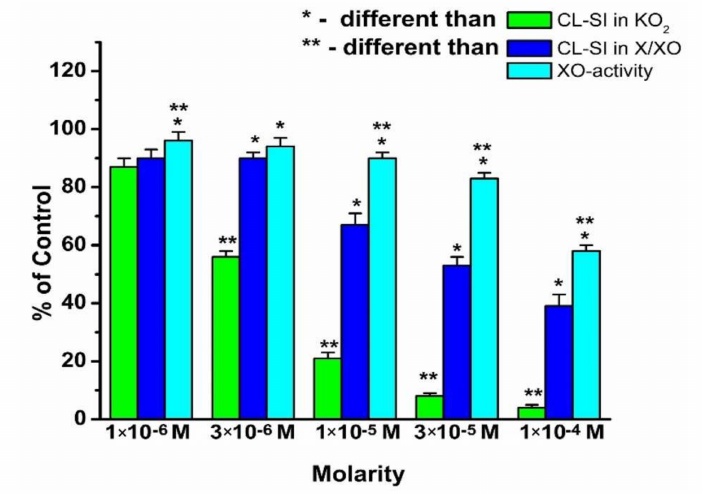
Figure 4. Radical-scavenging activity of LaAOA toward superoxide radicals formed in KO 2 and X/XO model systems, and activity of XO in the formation of uric acid (UA) in the X/XO model system. Data = mean ± StDev, p <